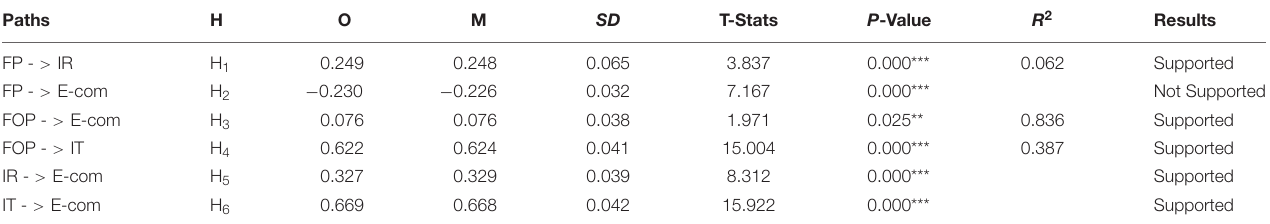
FIGURE 3 | PLS-bootstrapping for the structural model. TABLE 5 | Results for the structural